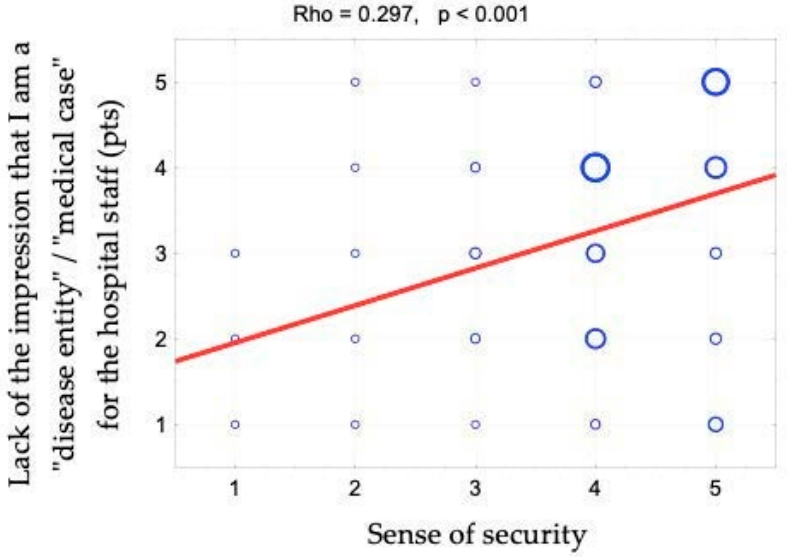
Figure 6. Correlation diagram between the sense of security (1—definitely not, 2—rather not, 3— partially, 4—rather yes, 5—definitely yes) and the feeling of a lack of the impression that I am a “disease entity”/“medial case” for the hospital staff and the value of Spearman’s rank correlation coefficient (rho).